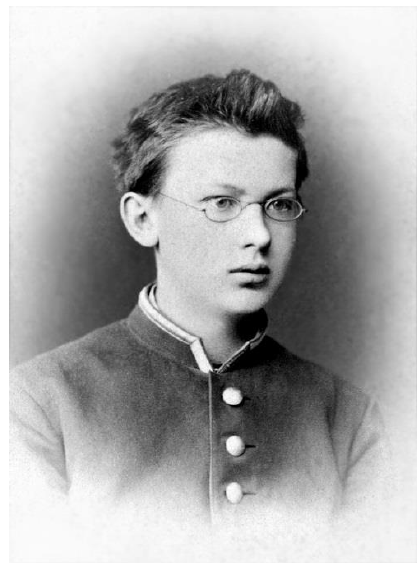
Figure 3. Volodymyr Vernadsky – gymnasium